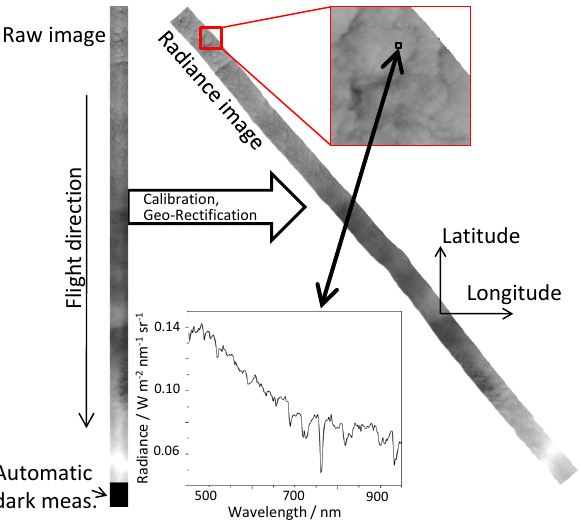
Fig. 2. Data processing of the AisaEAGLE imager. The raw im- age (left) in digital numbers (0–4095) is completed by an automatic dark measurement every five minutes. The radiometric calibration transforms the digital numbers into radiances. The geo-rectification projects each pixel of the image into the Earth reference system (longitude, latitude). Each pixel contains a full radiance